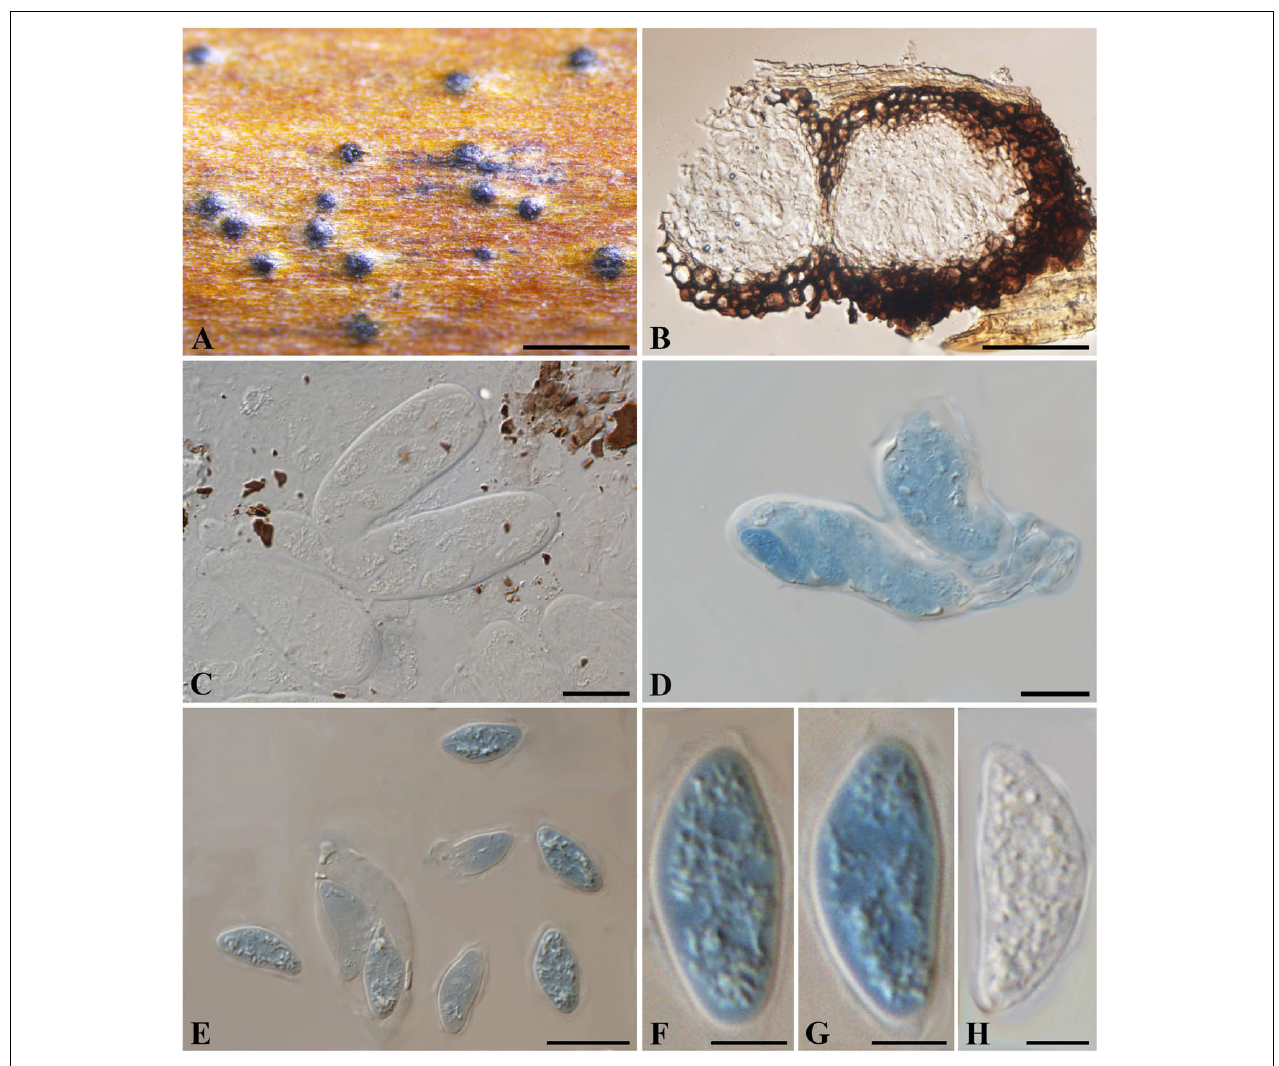
FIGURE 8 | Botryosphaeria aesculi (NYS f93, holotype ). (A) Ascomata erumpent through the bark of host twig. (B) Longitudinal section of ascomata. (C,D) Squash showing asci ( C in water, D in cotton blue). (E-H) Released ascospores ( E-G in cotton blue, H in water). Scale bars: (A) = 500 µ m, (B) = 50 µ m, (C-E) = 20 µ m, (F-H) = 5 µ